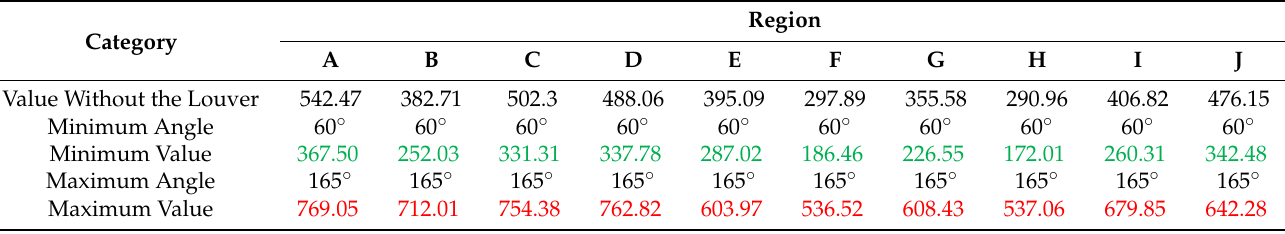
Table 8. Total thermal energy consumption in